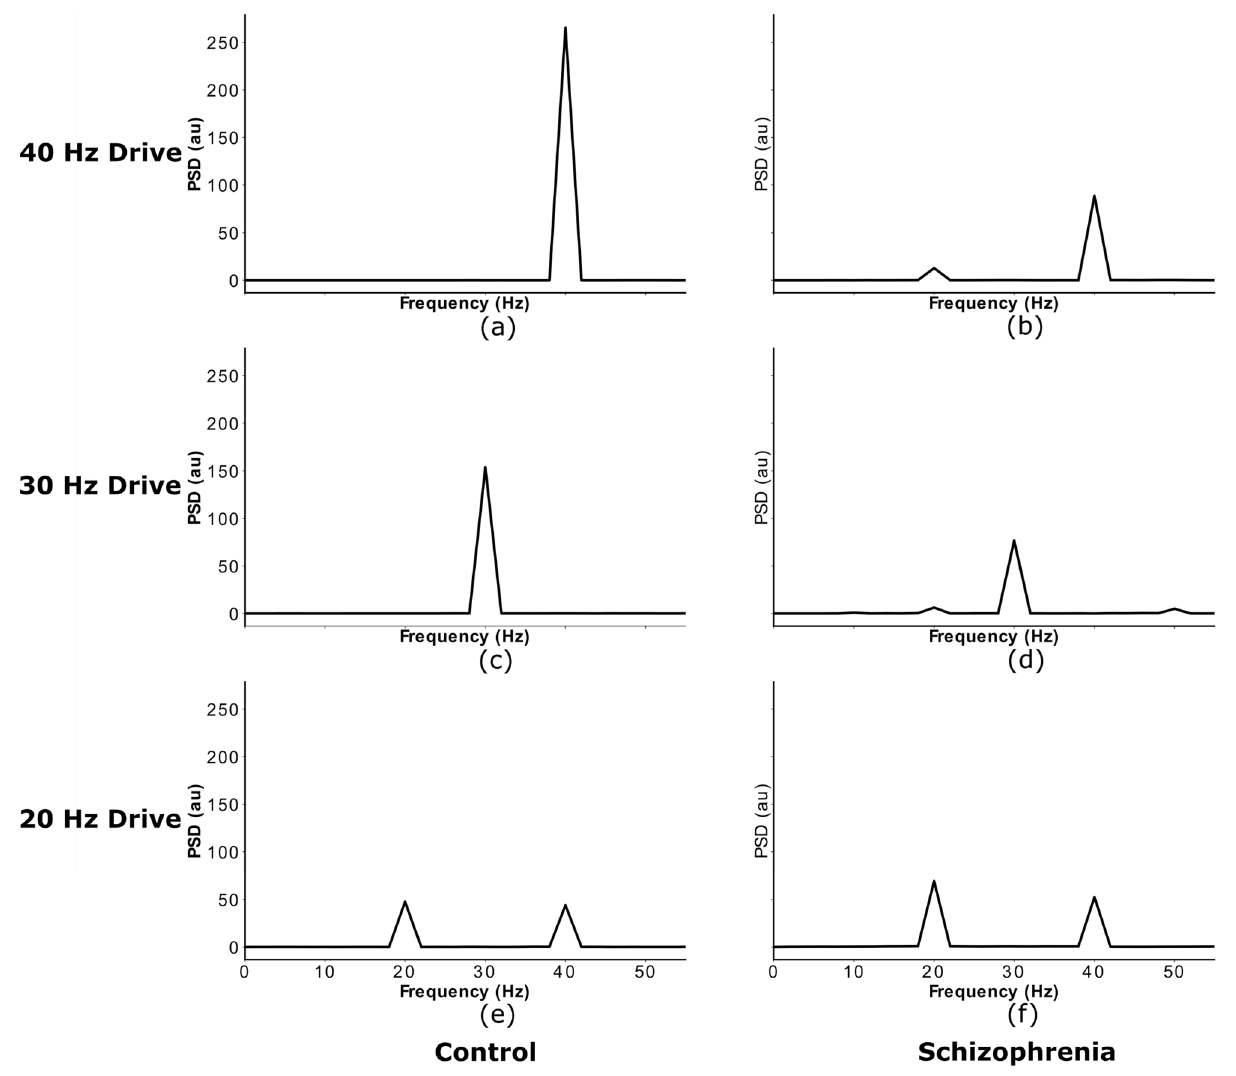
Figure 2. Power spectra of network responses to ASSR stimuli of different frequency. Power spectral densities of the simulated MEG signals from Fig. 1, again replicating earlier studies using this model 17,22